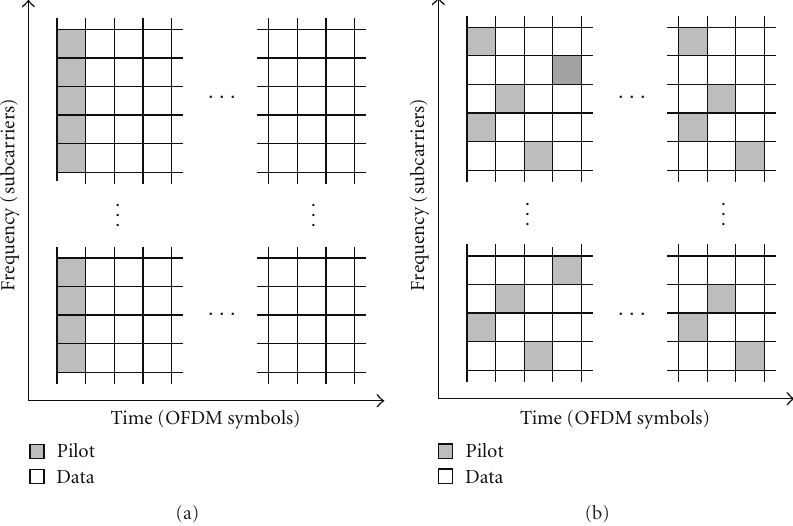
Figure 3: Pilot structure (a) preamble (b)